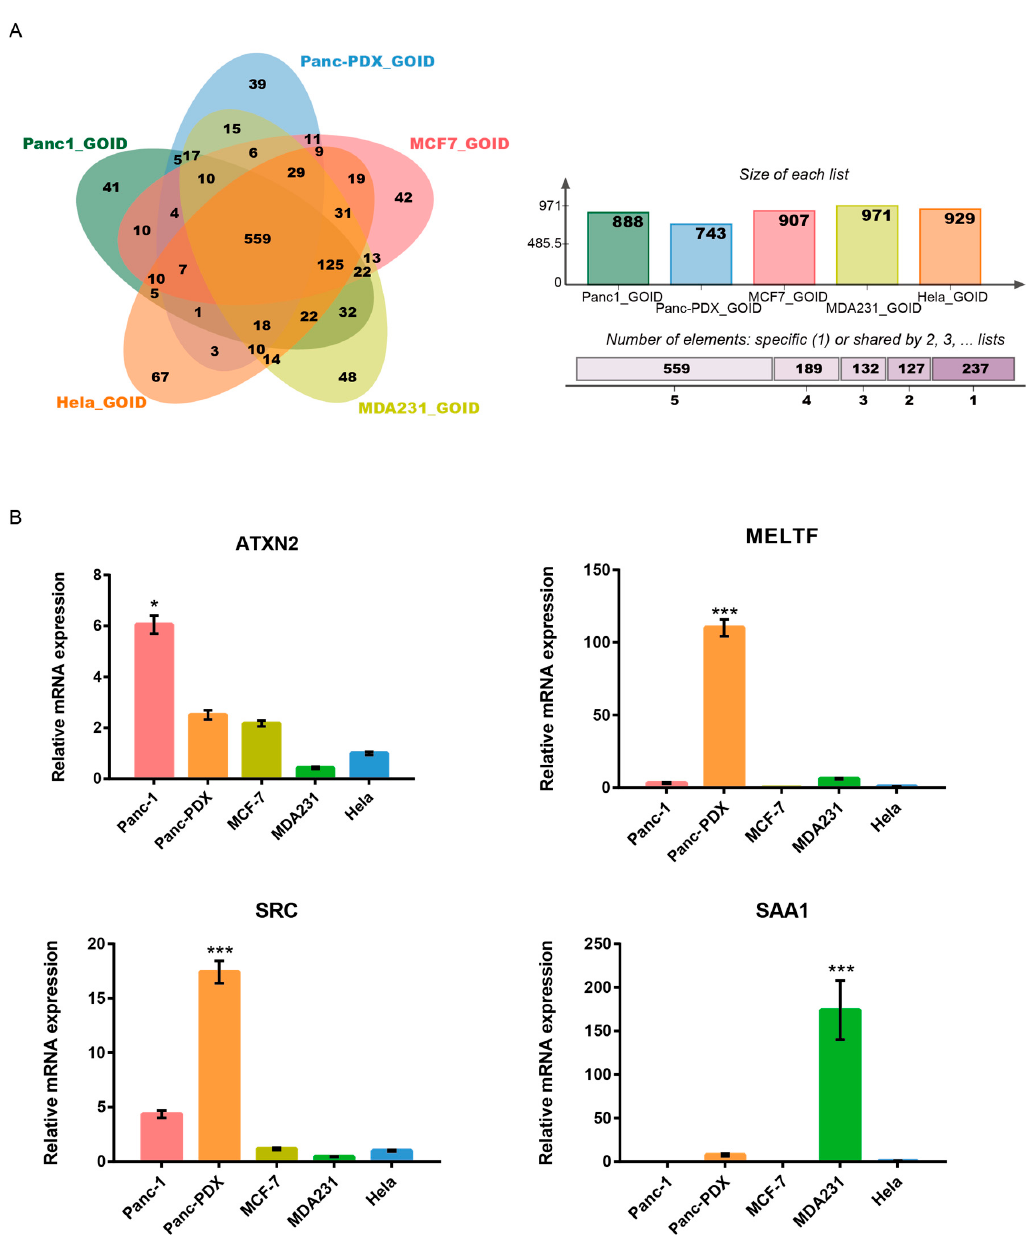
Figure 7. Screening for potential SiNR endocytosis ‐ related genes. ( A ) Venn plot of GO terms enriched from five types of cell membrane proteins. The center part of the plot stands for the 559 common gene sets that are contained in all five types of cells. The overlying parts surrounding the center cover the partial shared gene sets with specific types of cells. The outer single ‐ color parts are unique functional gene sets belonging to each single type cell. The top ‐ right panel shows the total GO terms enriched from every type of cell membrane protein pool. The right panel represents different shared levels of GO terms among the five types. ( B ) Real ‐ time PCR results show ATXN2 , MELTF , SRC , and SAA1 genes. A multiple t -test was performed with three biological replicates per group in GraphPad 6 (* p < 0.05, *** p < 0.001).